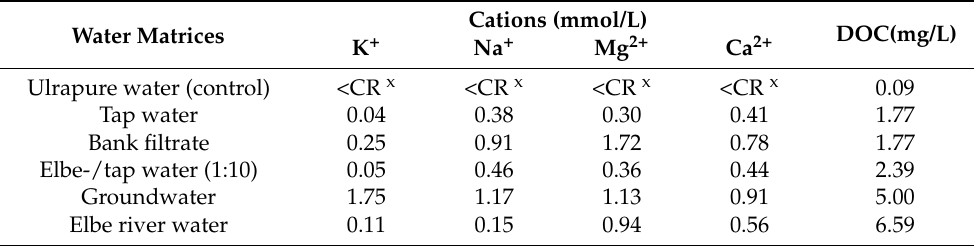
Table 7. Initial cation and DOC concentrations of the investigated natural water matrices. Water